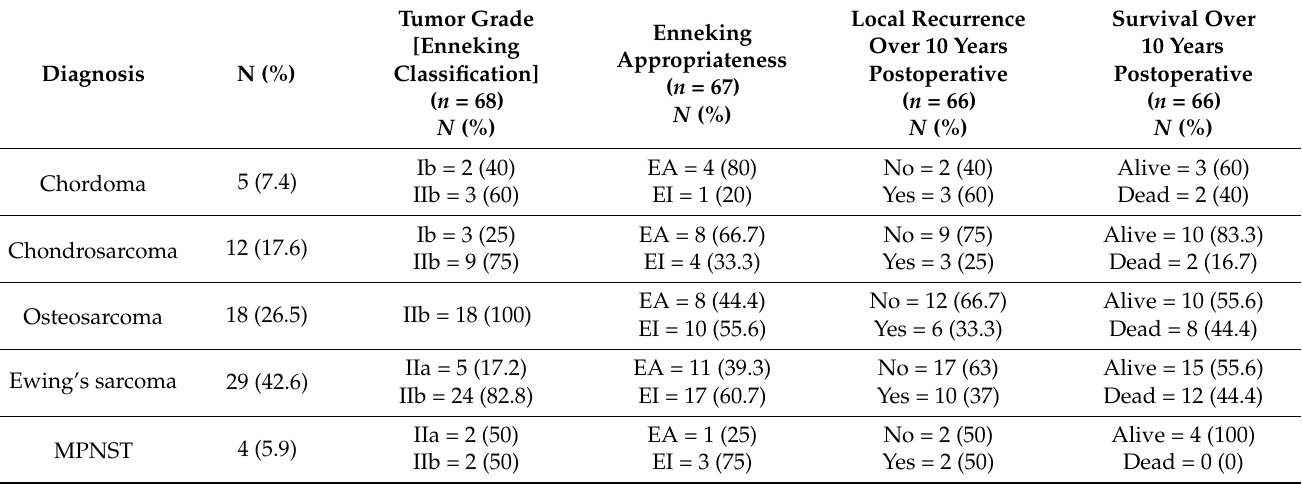
Table 6. Key parameters for each histotype regarding the overall number/percentage, tumor grade according to the Enneking classification, resection result, LR and